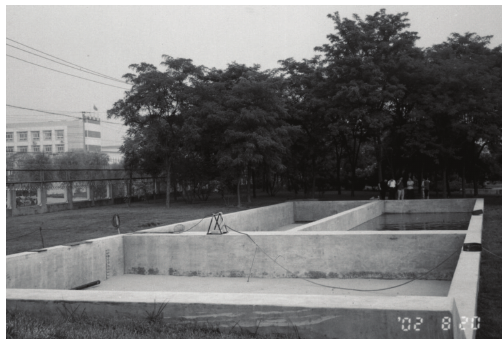
The solution for this grid can be calculated with (22).